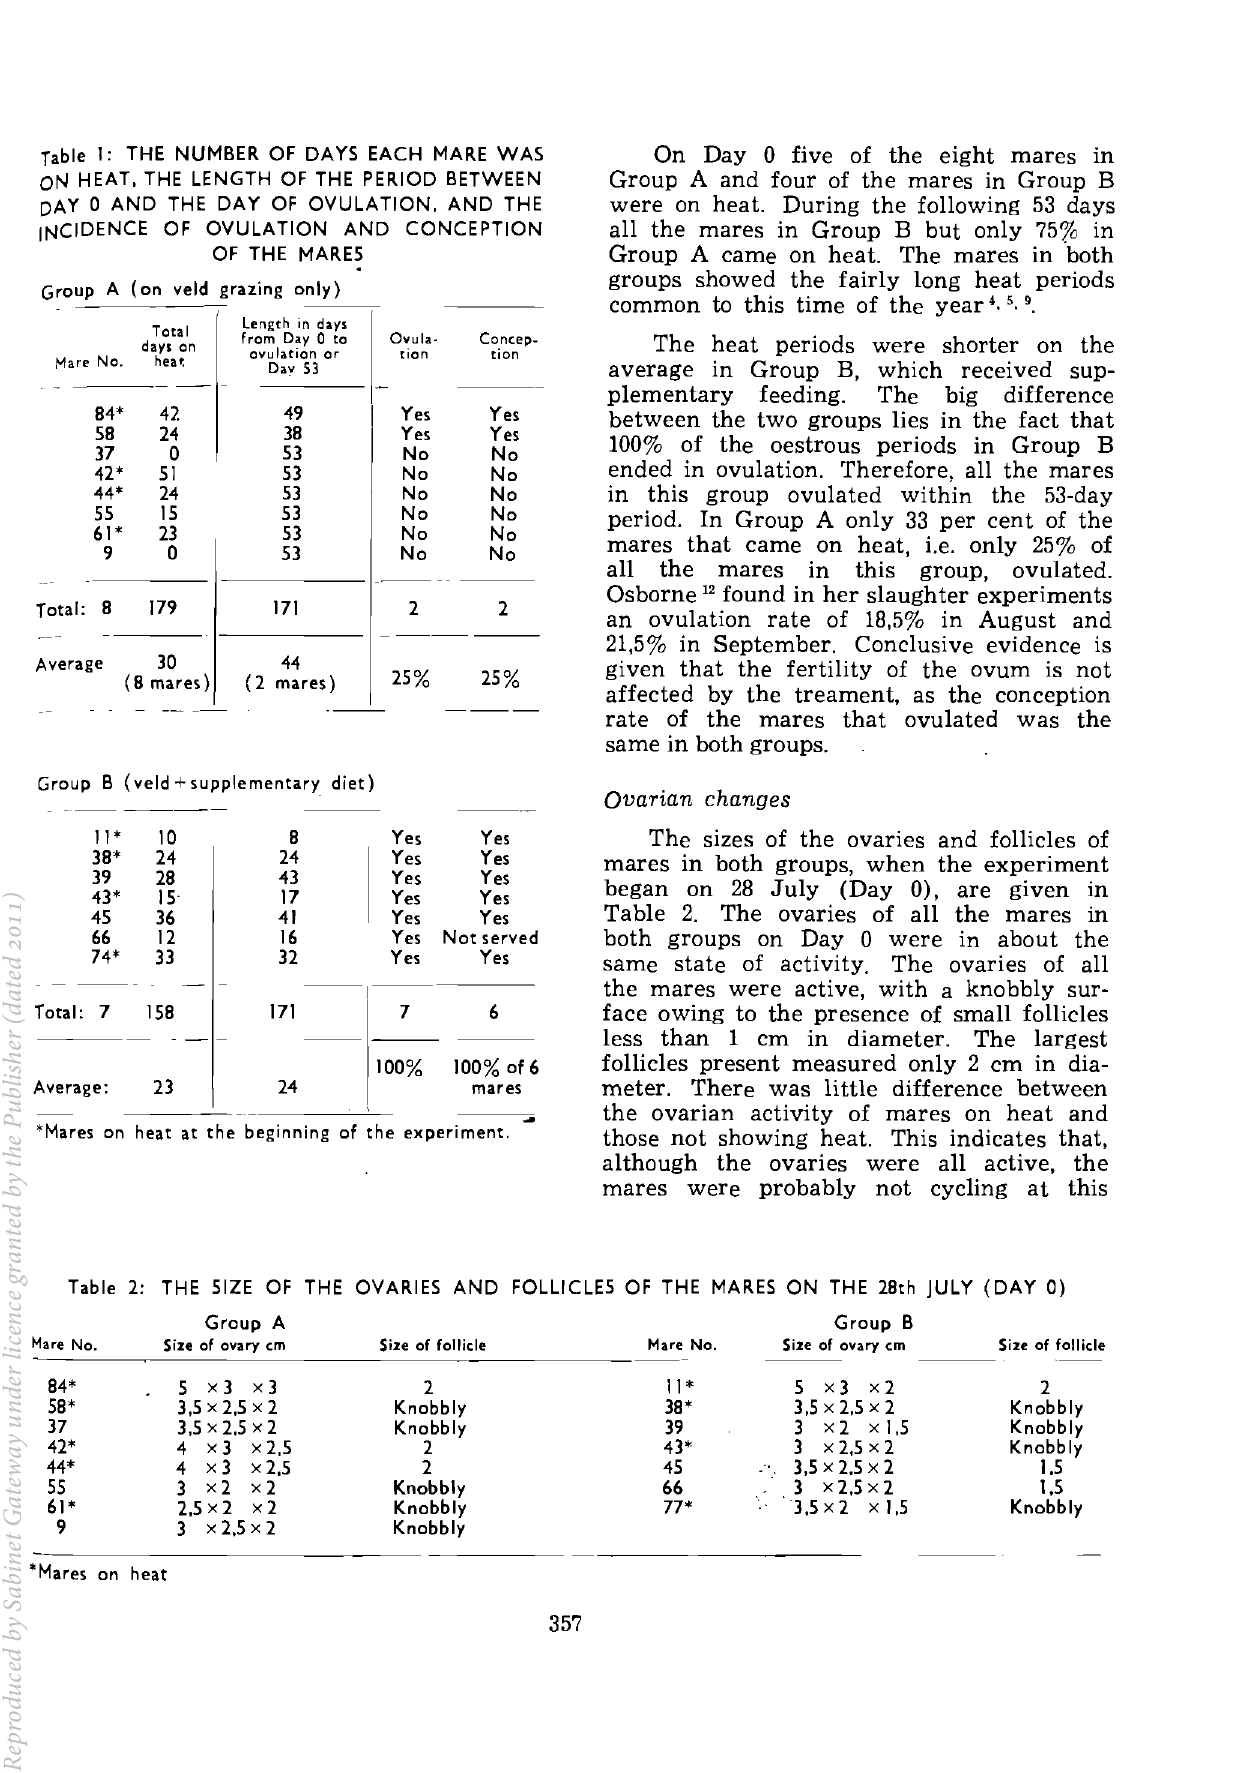
Table 2: THE SIZE OF THE OVARIES AND FOLLICLES OF THE MARES ON THE 28th JULY (DAY 0) Group A Group B Mare No. Size of ovary